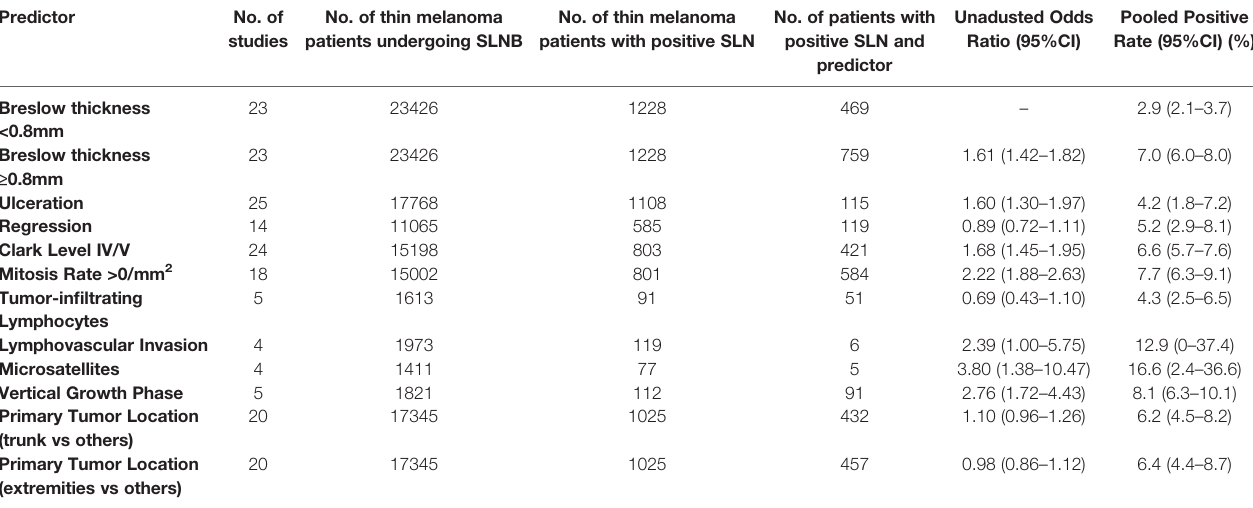
TABLE 2 | Predictive value of high-risk pathologic and clinical features for sentinel lymph node biopsy positivity. Predictor